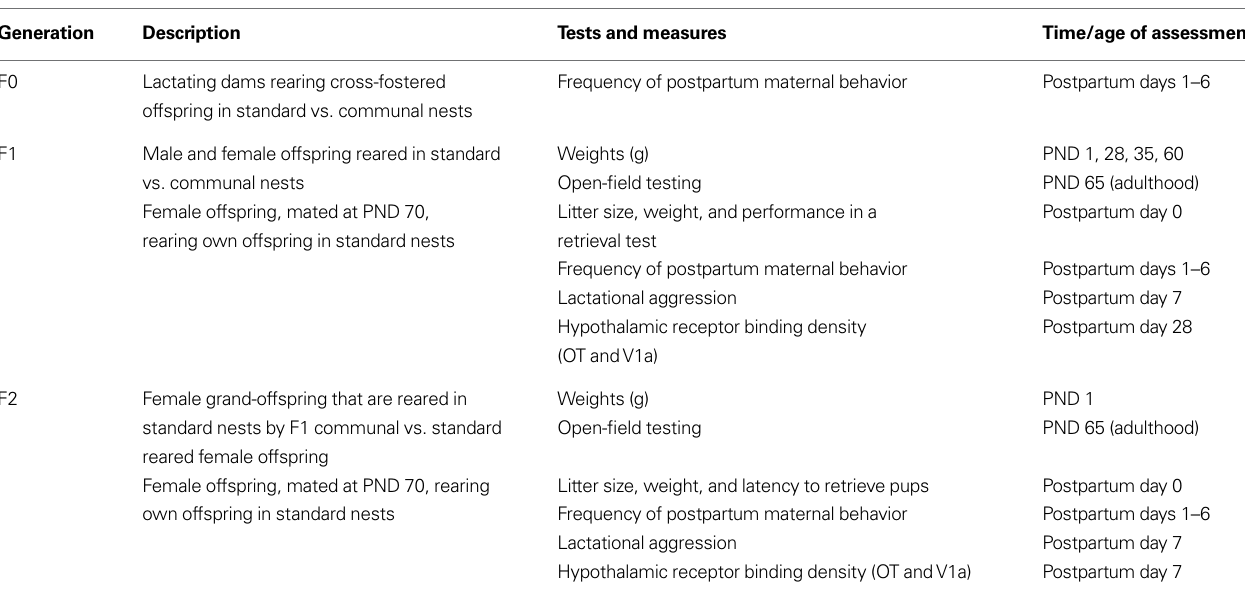
Table 1 | Summary of research